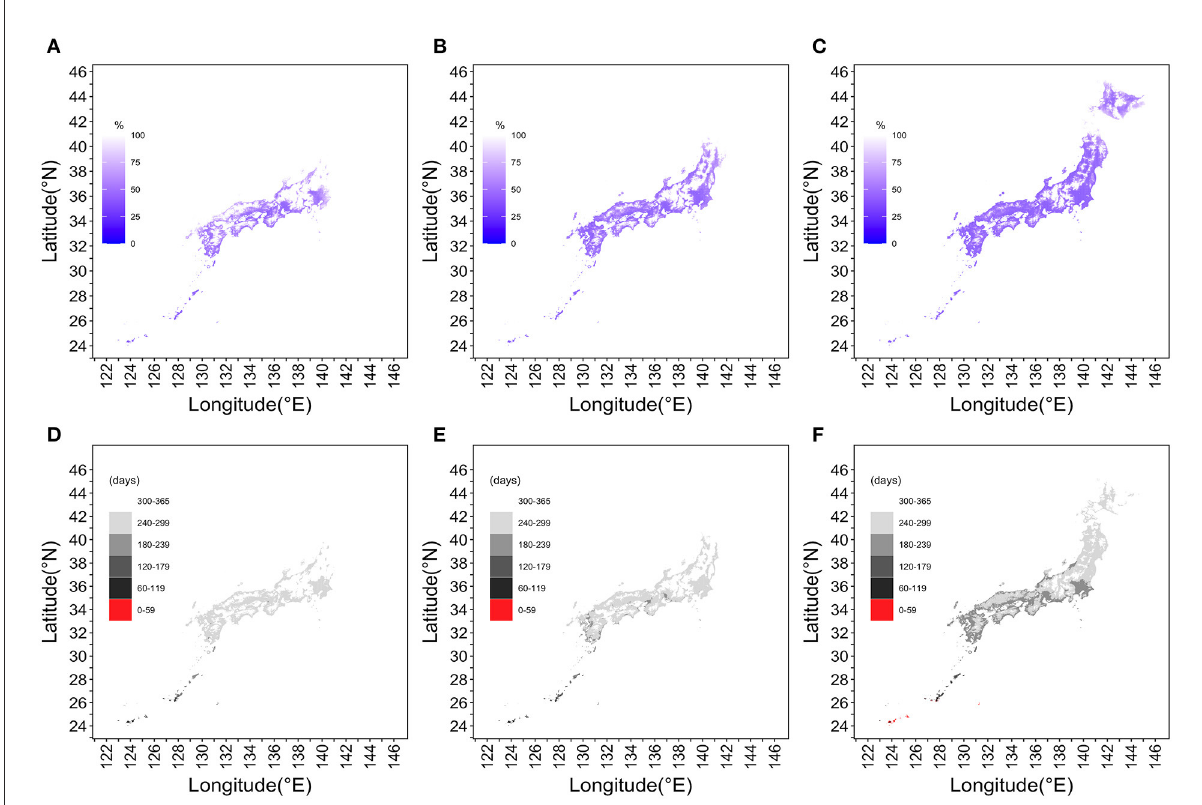
FIGURE5 Snapshot of the extinction probability and interepidemic period across Japan in 2030, 2050, and 2100 under the RCP8.5 scenario. (A,D) depict the year 2030, (B,E) the year 2050, and (C,F) the year 2100. (A–C) The probability of extinction in the Tohoku region and Hokkaido on July 1, 2030. However, in 2050, the epidemic risk area had moved northward and from coastal to inland areas. Although merely a snapshot, our mapping shows that the epidemic risk is extended over the entire Hokkaido region by 2100. In (D–F) , IEPs are divided into six discrete categories and Japan is mapped at a resolution of 1 km 2 . The darker the gray color, the shorter the IEP and the longer the period of dengue epidemic risk. The RCP8.5 scenario for the year 2100 shows that parts of the Okinawa Islands will have IEPs of fewer than 60 days, and southwestern Hokkaido will have dengue transmission risk periods longer than 60